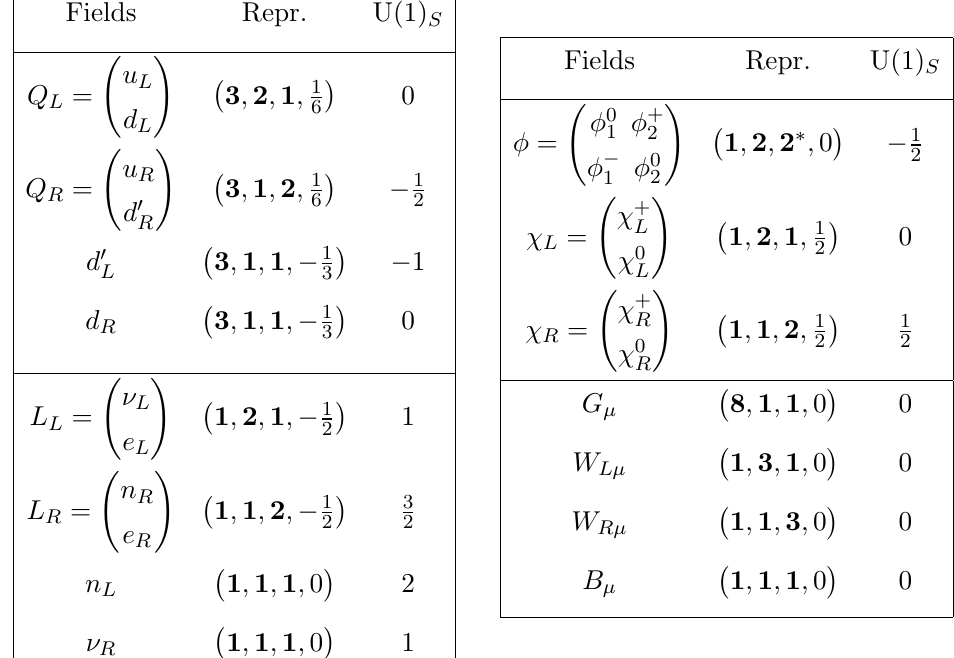
Table 1 . ALRSM particle content, given together with the representation of each (cid:12)eld under SU(3) c (cid:2) SU(2) L (cid:2) SU(2) R 0 (cid:2) U(1) B (cid:0) L (second column) and the U(1) S quantum numbers (third column). We consider the matter sector (left panel), the gauge sector (lower right panel) and the Higgs sector (upper right panel)